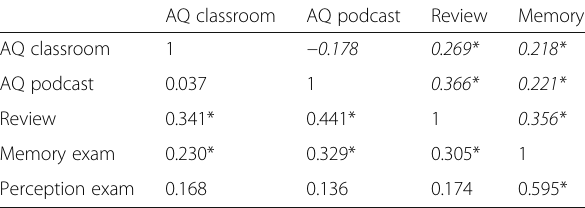
Table 2 Correlation between advance quizzing, review and exam scores in first-year students (normal font), and second- year students (italics), respectively